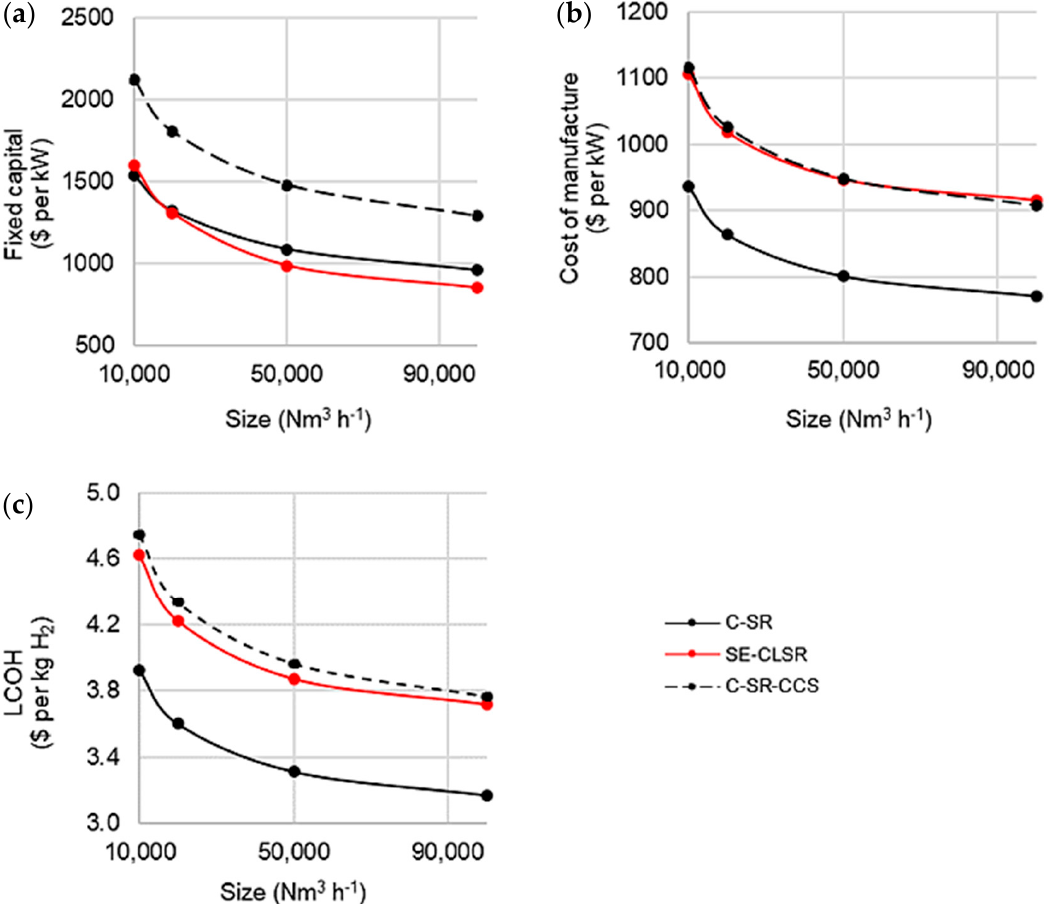
Figure 6. Cost analysis of base case C-SR and SE-CLSR processes with steam export: ( a ) fixed capital costs, ( b ) cost of manufacture, and ( c ) LCOH.